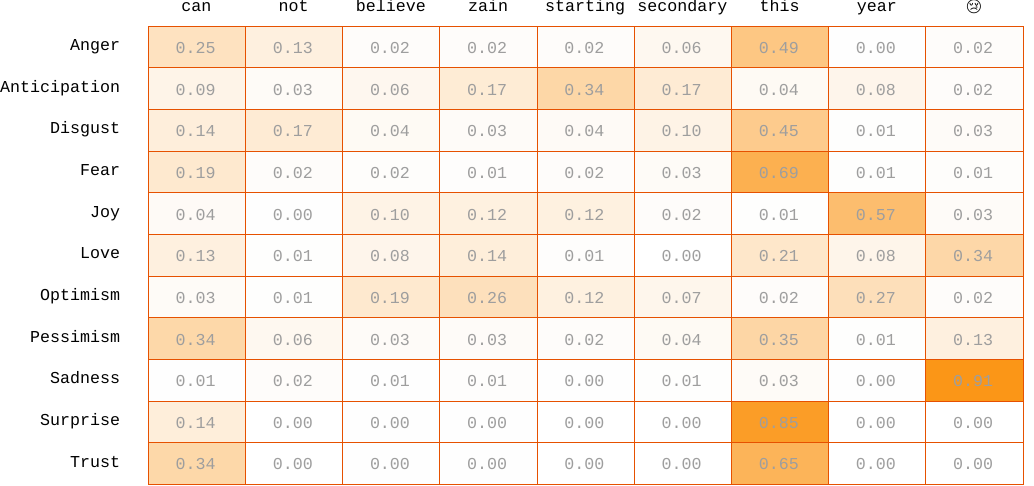
Figure 7. Attention visualization example. Golden labels are { sadness , surprise } and predicted labels are { love (0.74) , sadness (0.98)